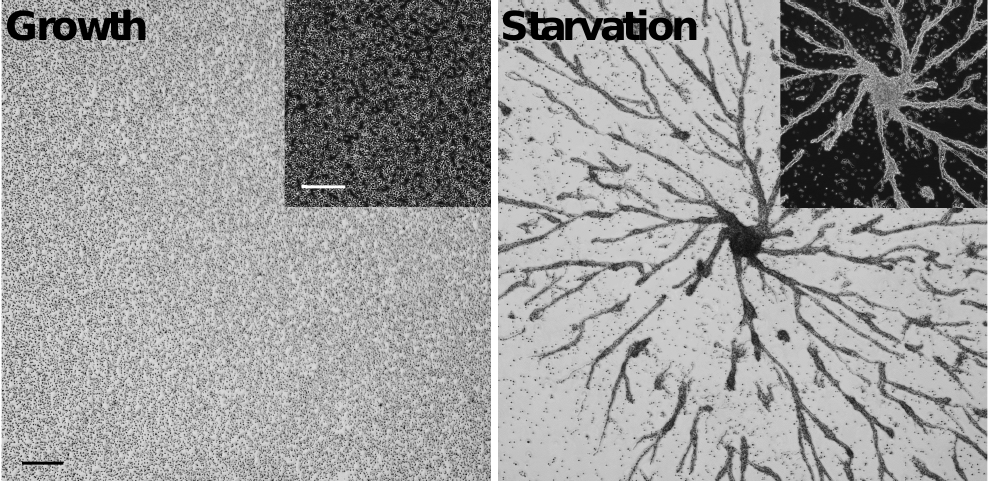
Figure 1. Growth and starvation of Dictyostelium cells. Cells were grown overnight in Petri dishes to confluency, after which time, growth-phase cells and cells starved for 6 h in KK2 buffer were harvested. The images shown are representative of three biological replicates. Scale bar = 250 µ